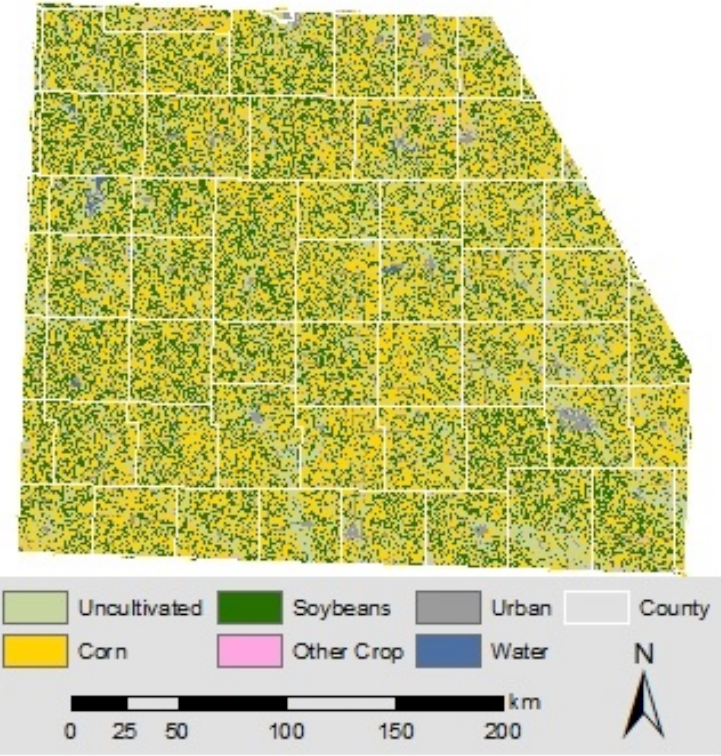
Fig. S1 Generalized Crop Data Layer from 2012